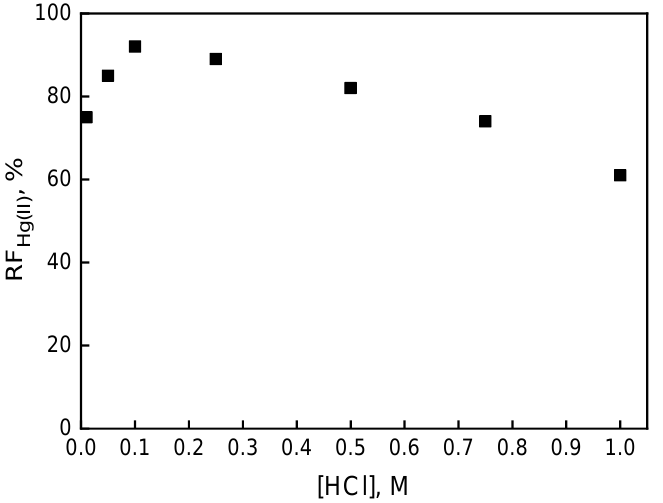
Figure 7. The recovery factor (RF) of Hg(II) ions vs. HCl concentration in the source phase. Source phase: 1.0 × 10 −6 M Hg(II); membrane: 19 wt.% of CTA, 4 wt.% of KP, 77 wt.% of o -NPOE; receiving phase: 0.1 M NaCl.